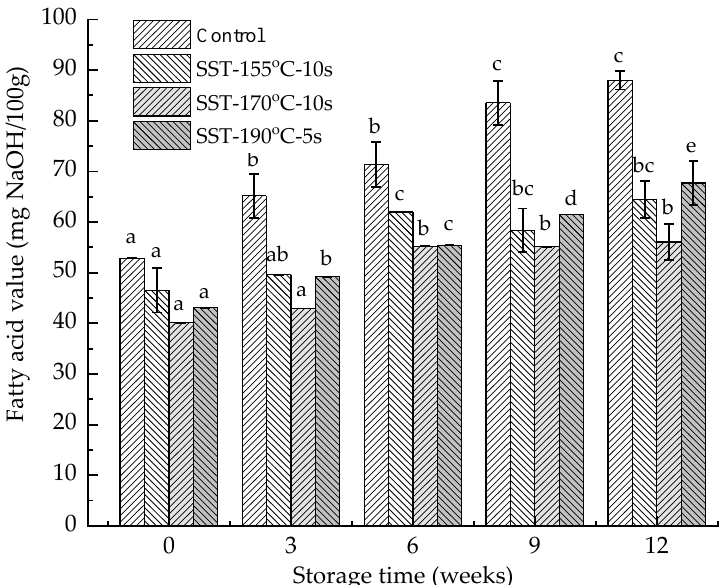
Figure 2. Effect of superheated steam treatment on fatty acid value of dried whole wheat noodles during storage. The lowercase letters in the column chart indicate the significant difference of the same sample in different storage time at p < 0.05. SST: superheated steam treatment.